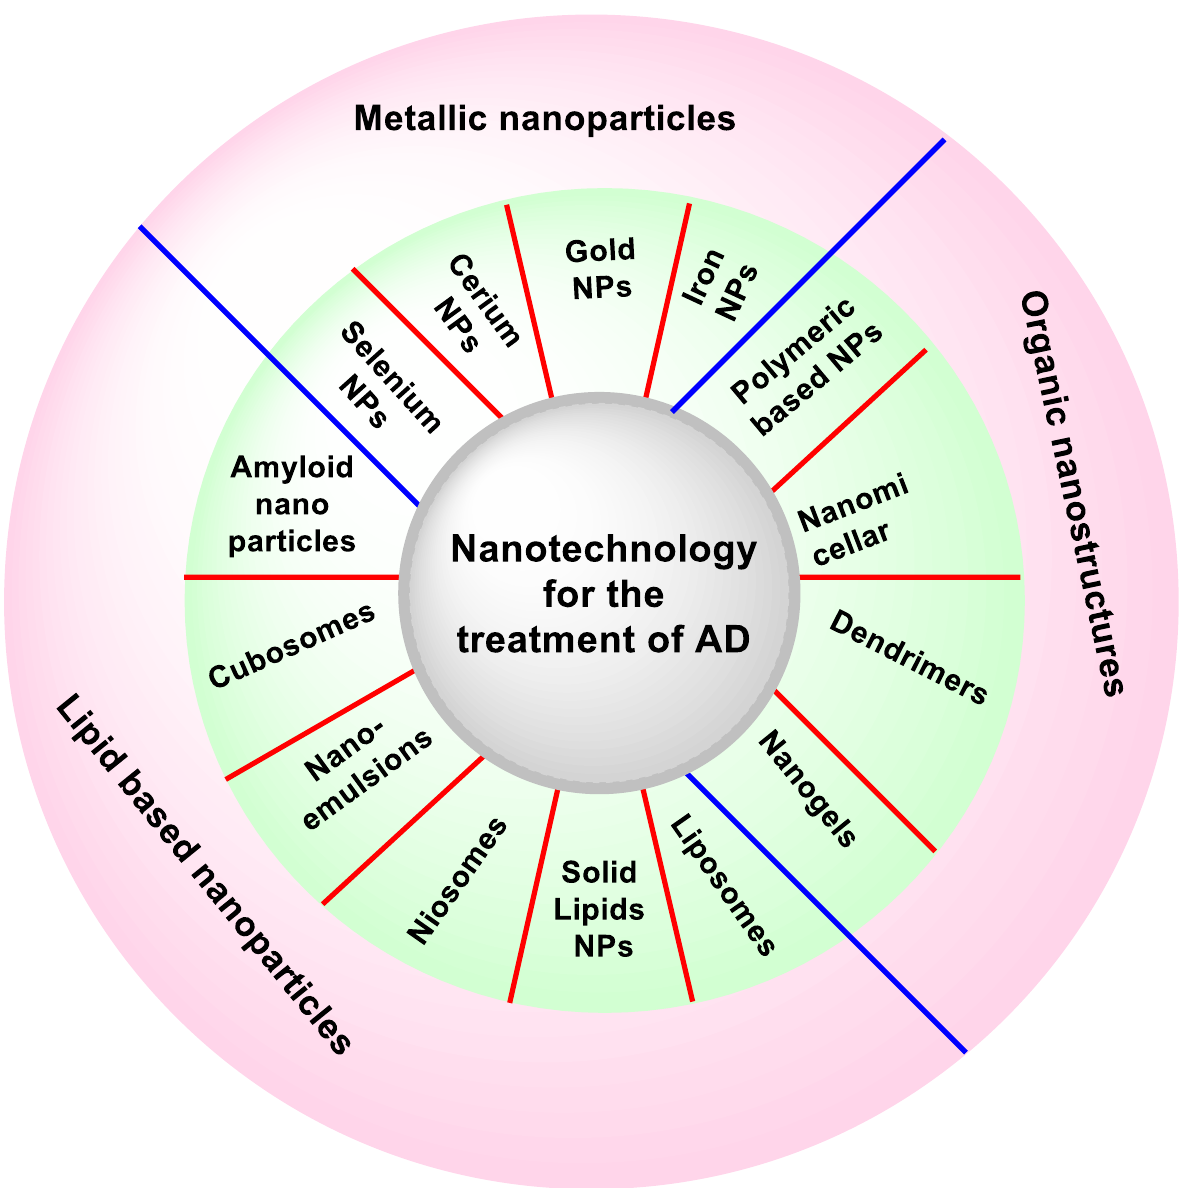
Figure 8. Different nanotechnology approaches for the treatment of AD.